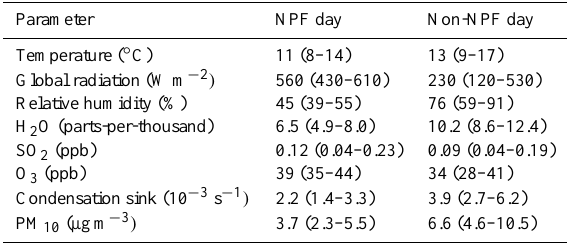
Table 1. Conditions observed at Hyytiälä during NPF and non-NPF days between 08:00 and 11:00 (local time) in months May–June 1996–2012. For each variable the median value is given and the interquartile range (25th and 75th percentiles) is shown in brackets. The median and interquartile values are calculated from all data at 30min time resolution in the time window